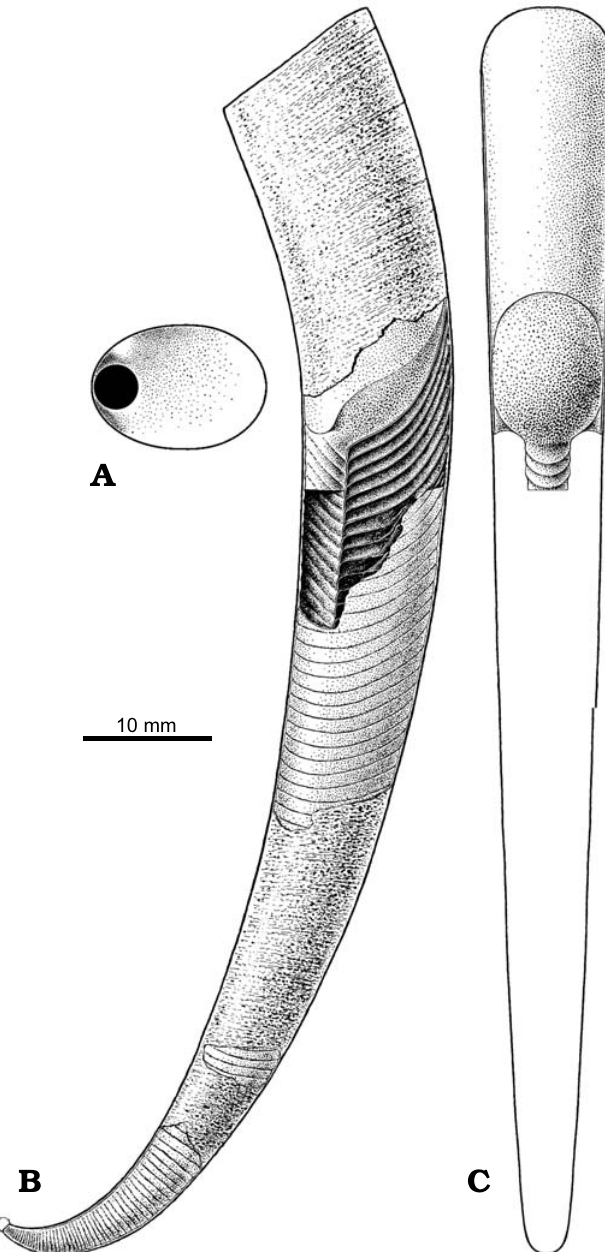
Fig. 13. Restoration of the conch of Ruthenoceras elongatum Korde, 1949 from the Ust-kut Formation of Siberia, with hypothetical subspherical apex based mostly on ZPAL N. IV/4 (Fig. 5A). A . Septum in proximal view. B . Conch in lateral view with the body and proximal part of sipho exposed. C . The body and a portion of sipho in dorsal